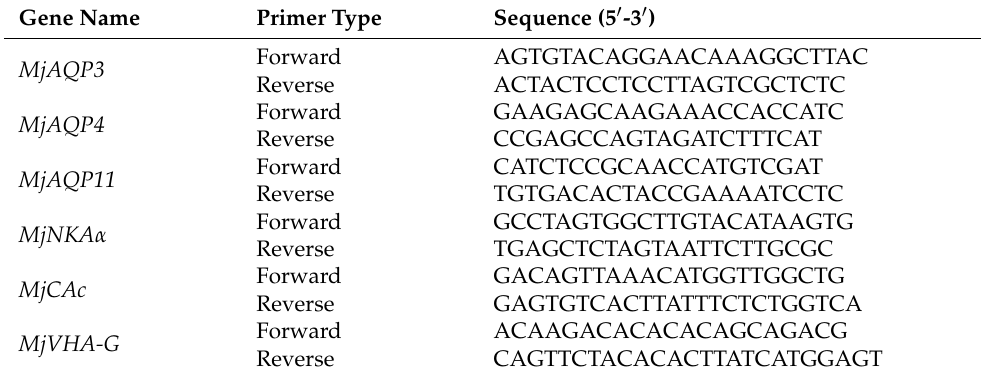
Table 1. Specific primers used for gene